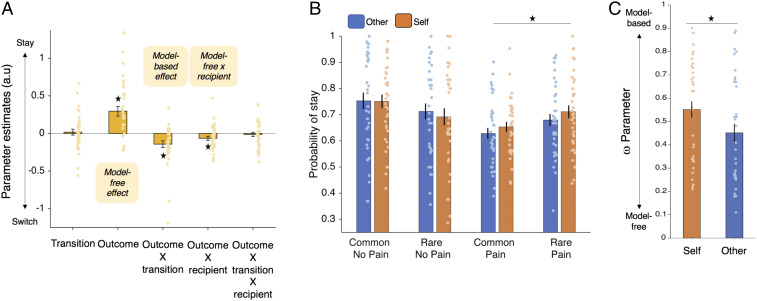
Model-free and model-based choices when avoiding harming oneself and others. (A) Logistic regression coefficients predicting first-level stay/switch choices (mean ± SEM). Participants exhibited a main effect of staying after no pain, which indicated model-free behavior [t(35) = 4.618, P < 0.001, CI for beta estimate: 0.17, 0.42, Cohen’s d = 0.77] and a outcome × transition interaction, which indicated model-based behavior [t(35) = −3.173, P = 0.003, CI for beta estimate: −0.23, −0.05, d = −0.53]. Intriguingly there was also an outcome × recipient interaction [t(35) = −2.31, P = 0.027, CI of beta estimates −0.12, −0.008, d = −0.39] showing that participants were more model-free, and thus more likely to switch after pain and stay after no pain, independent of transition type, when making choices for another person. (B). The probability of repeating a choice at the first level (“stay”) is plotted as a function of the transition and outcome on the previous trial. This shows that the outcome × recipient interaction in A is mostly driven by fewer stay trials after pain, regardless of transition (two rightmost blue vs. orange bars). Thus, the more pronounced model free behavior for others is mostly driven by a lower probability of staying after pain outcomes rather than a higher probability of staying after no pain outcomes). (C) ω estimates from the best-fitting model showed that the ω parameter was significantly lower for other (0.45) than self (0.55), consistent with the regression analyses that showed people were more model-free when avoiding harm to others compared to self (P < 0.02). Asterisks indicate significant difference at P < 0.05.